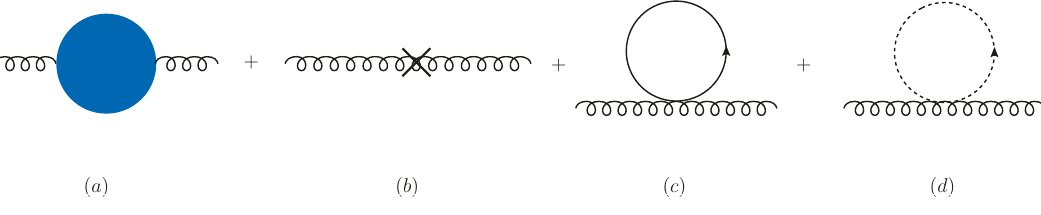
Figure 2 . One-loop self energy diagrams of gluon in lattice perturbation theory. (a) denote the diagrams which have corresponding diagrams in the continuous limit. (b) is a counter-term which arises from the measure of path integral. (c) and (d) are tadpole diagrams involving a quark or ghost loop, which only exist in lattice perturbation